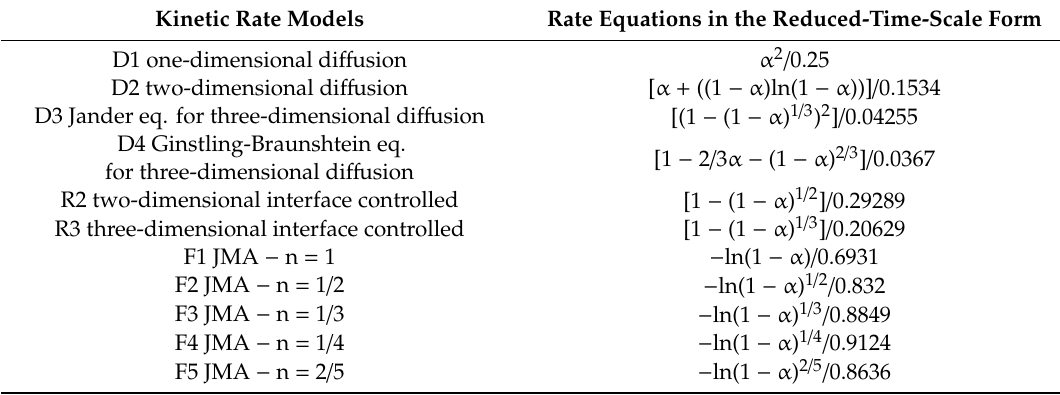
Table 1. Summary of integral expressions for di ff erent reaction models